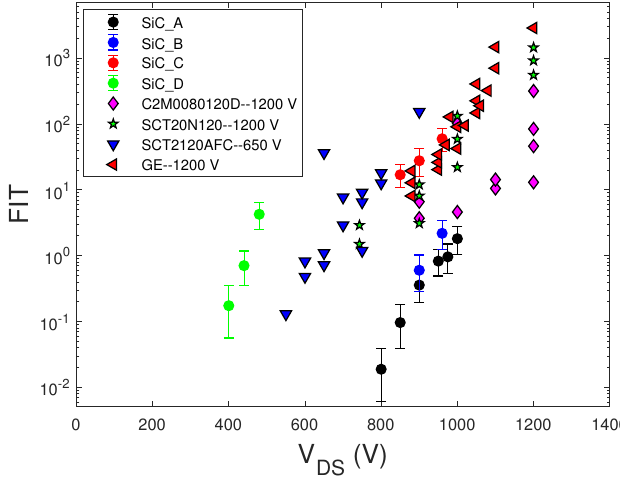
Figure 5. FIT data at sea level of the STMicroelectronics SiC MOSFETs ( • ) with the 95% confidence intervals. Data of the commercial SiC MOSFETs C2M0080120D, SCT20N120-1200 V, and SCT2120AFC-650 V from [13] and GE-1200 V from [27].